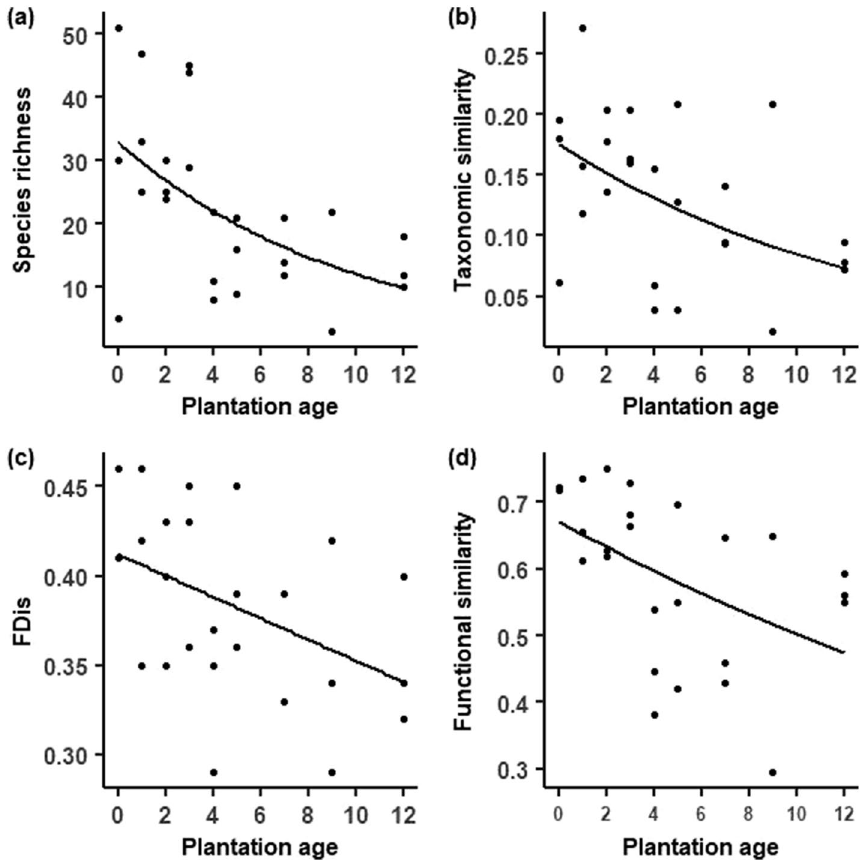
Figure 2. Changes of plant diversity facets along eucalypt forest cycle in grassland context. ( a ) Species richness (Z = − 3.49, p < 0.001) ( b ) taxonomic similarity (1-βSor, Z = − 2.689 p = 0.007) ( c ) alpha functional diversity (FDis, T = − 2.58 p = 0.02) ( d ) functional similarity (1-FSor, Z = − 2.74 p = 0.01). Grassland sites were pooled for measuring similarity indexes.